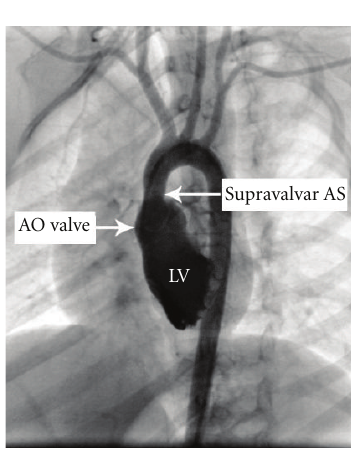
Figure 1: Elfin faces.